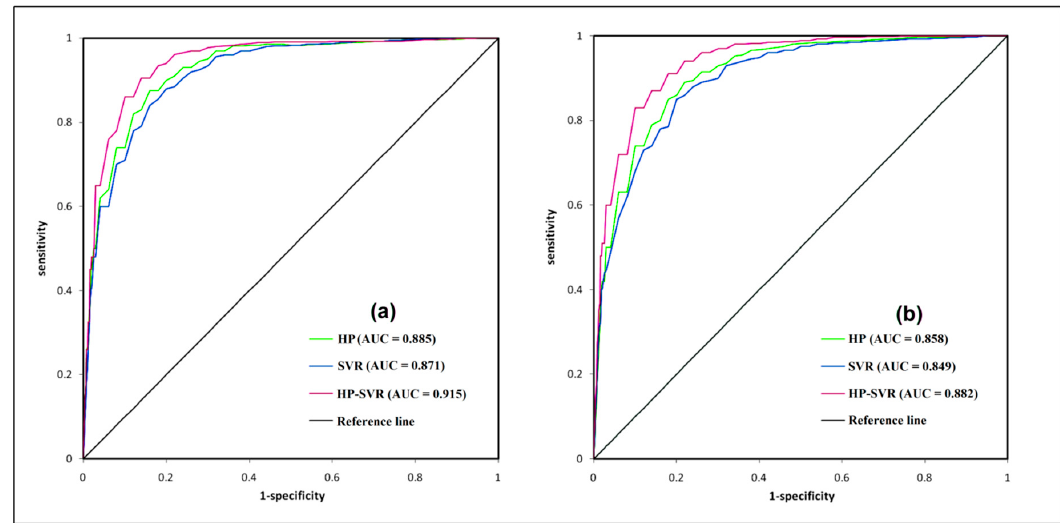
Figure 8. Receiver operating characteristics (ROC) curve analysis for ( a ) training and ( b ) testing dataset.